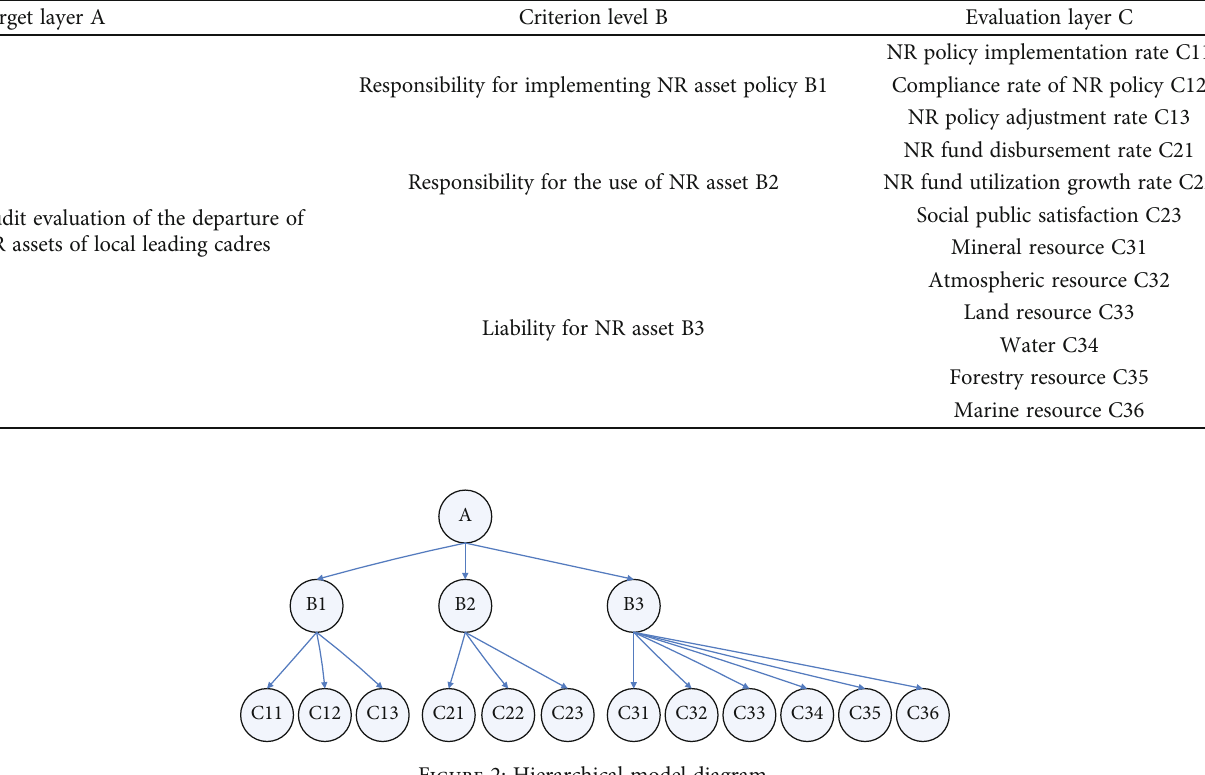
Table 1: Speci fi c indicator system for external management of NR assets by local